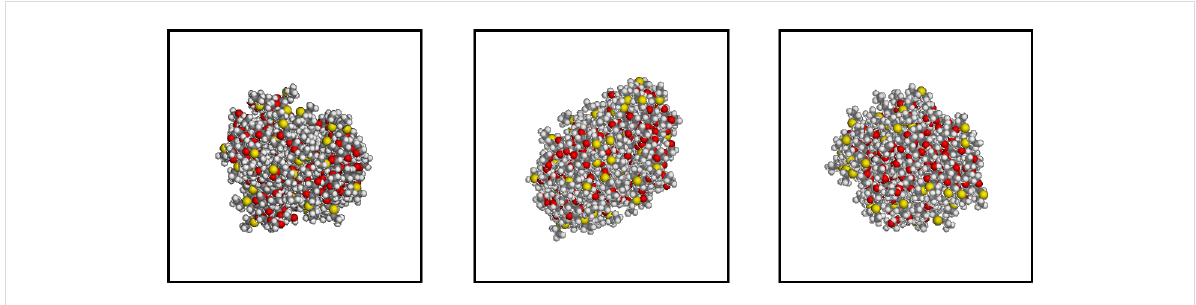
Figure 1: The aggregate of eight molecules of the aCD of Scheme 1 with n = 0, obtained from the first trial random arrangement of eight molecules in a periodic cell after the MD run of 100 ns. The three projections are taken along the cell x -axis, the y -axis, and the z -axis from left to right.